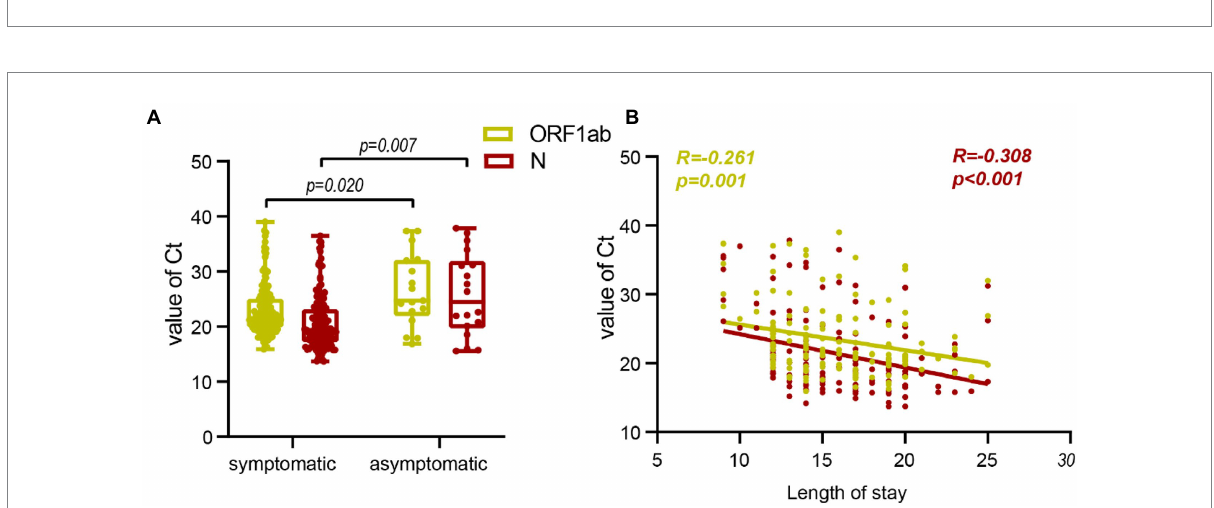
FIGURE 4 Correlation between Ct value and symptoms onset and length of stay. (A) , Comparison of admission Ct values between patients with symptoms and asymptomatic patients. (B) , Correlation between admission Ct value and length of